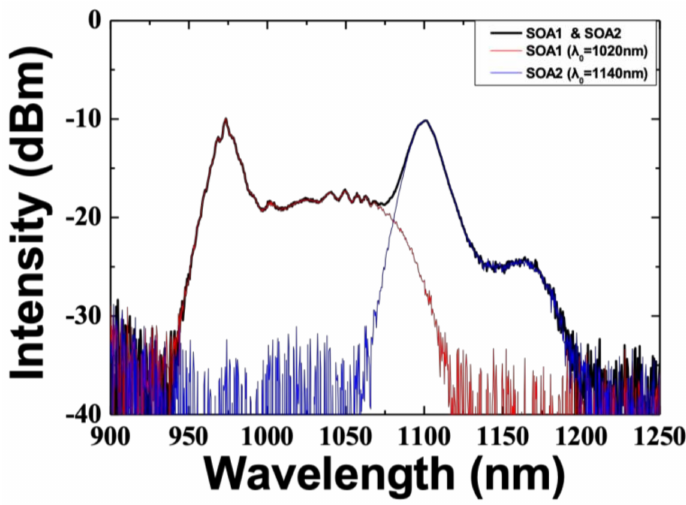
Figure 2. ASE spectra of two